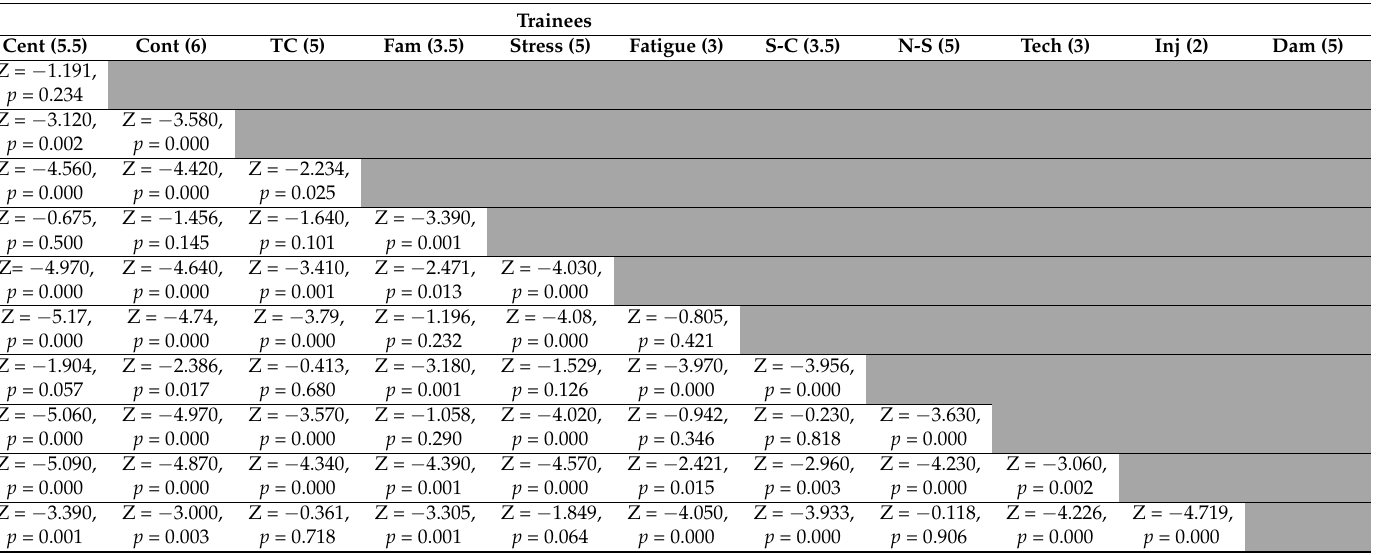
Table A6. Differences in risk perception factors within